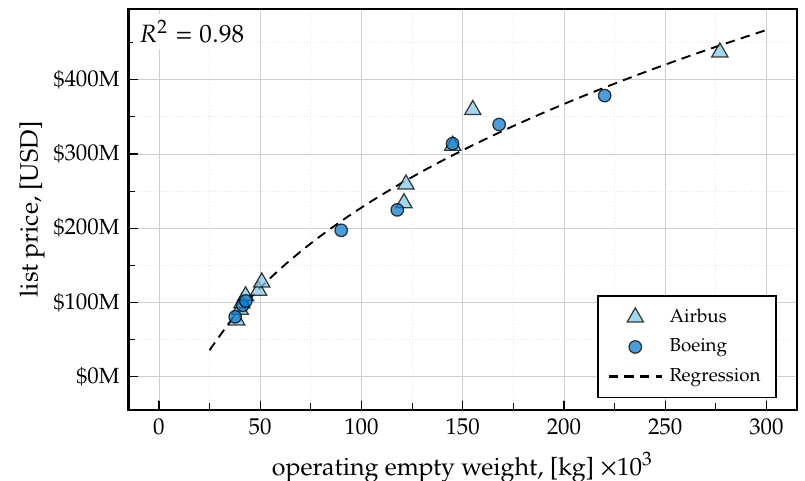
Figure 6. LYFE’s default weight dependent estimation of the aircraft list price (in 2018 USD).